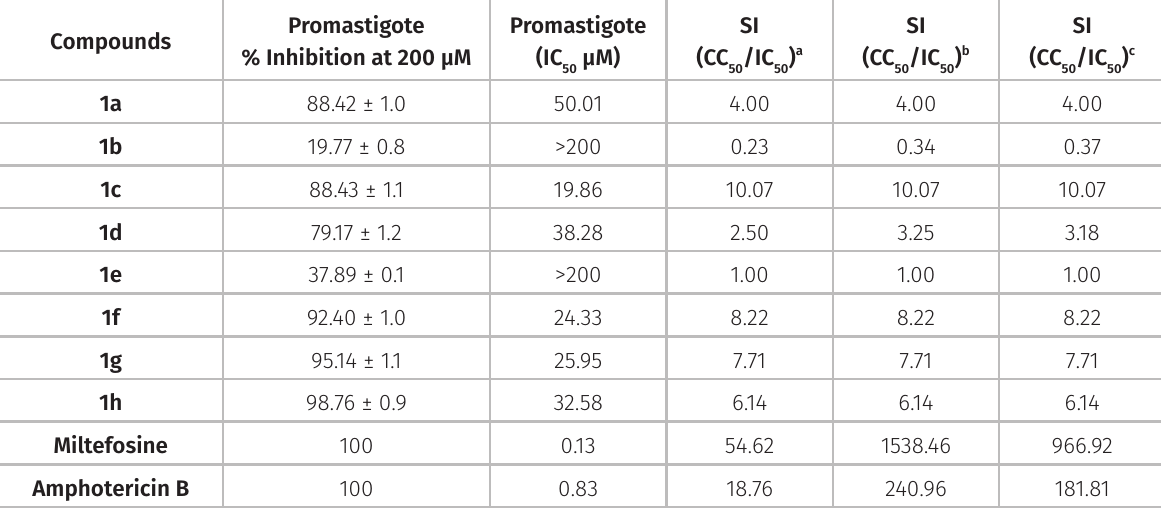
Mean ± Standard Deviation; SI: CC (HepG2). Selectivity results in absolute